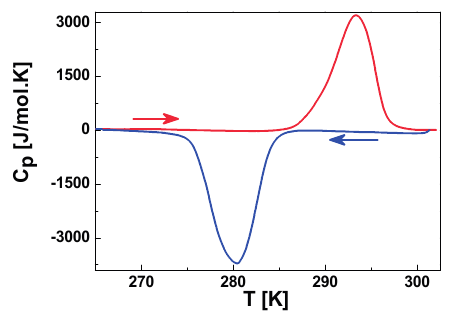
Figure 3. DSC curves for [Fe(hyetrz) 3 ]I 2 ·H 2 O over the 265–303 K temperature range.